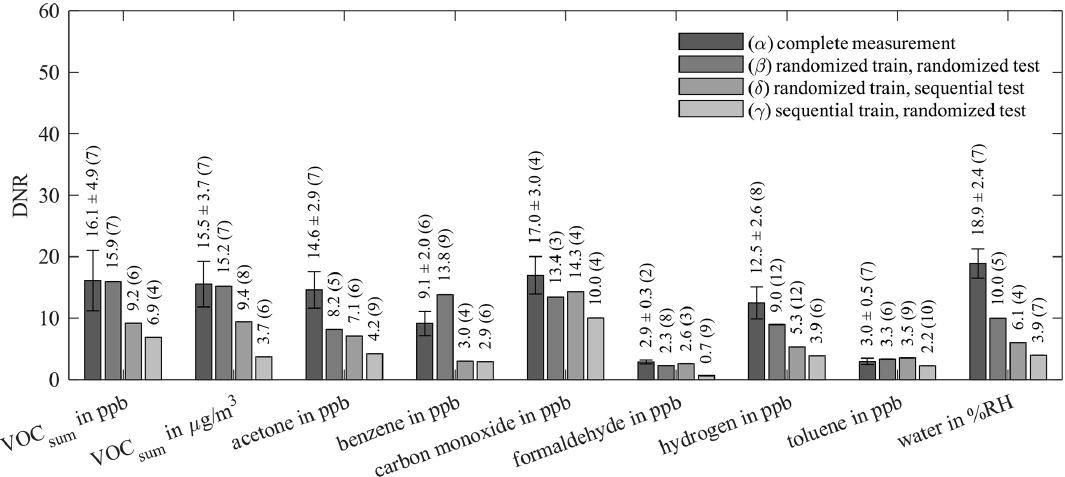
Figure 9. Dynamic range (DNR) of AS-MLV-P2 for different training and testing models. All models use 10-fold cross-validation for hyperparameter optimization; the resulting number of PLSR components, determined with Eq. (2), is given in parentheses. A detailed description of ( α )–( δ ) is given in Table 4.